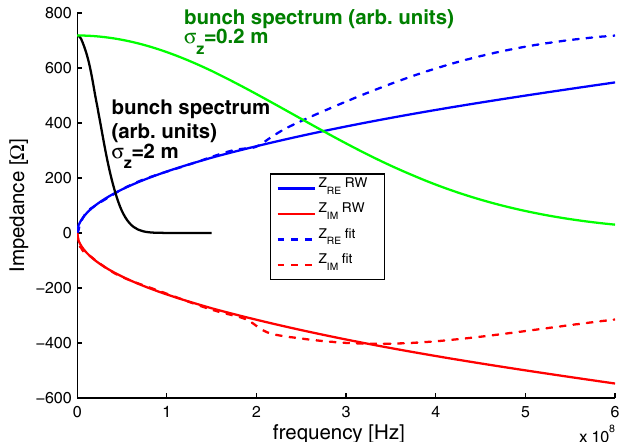
FIG. 17. Real and imaginary part of the longitudinal resistive wall impedance at low frequency compared with a fit of 18 resonant modes. In black and green two Gaussian bunch spectra of rms lengths of 2 and 0.2 m, respectively.